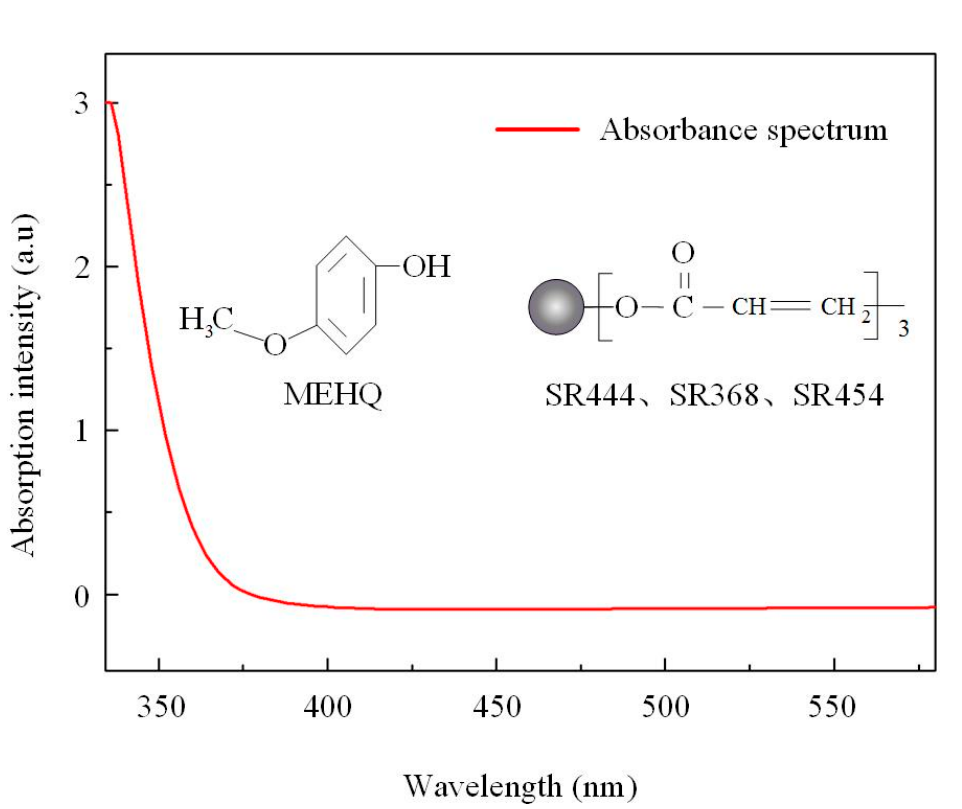
Figure 1. The single-photon absorbance spectrum of the photoresin used in this work. The monomers used in the photoresin are SR368, which was used to improve the chemical reactivity for high photosensitivity and mechanical strength against the damage and the shrinkage during the developing process, and SR444, which was introduced to keep the viscosity from decreasing the photoinhibition efficient, and SR454, which was used to improve the mechanical strength of the photoresin.